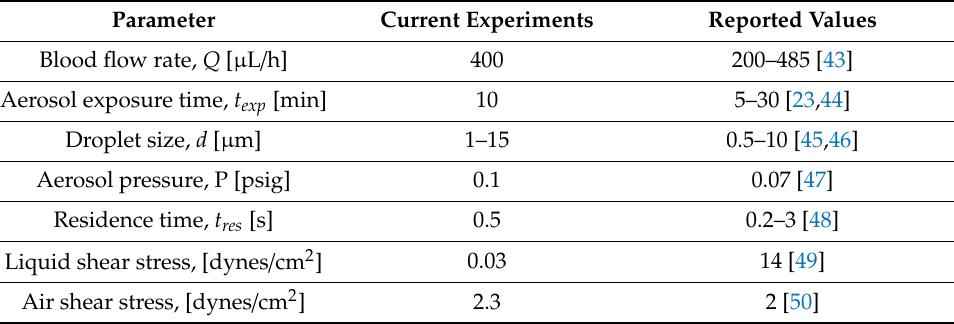
Table 1. Aerosol